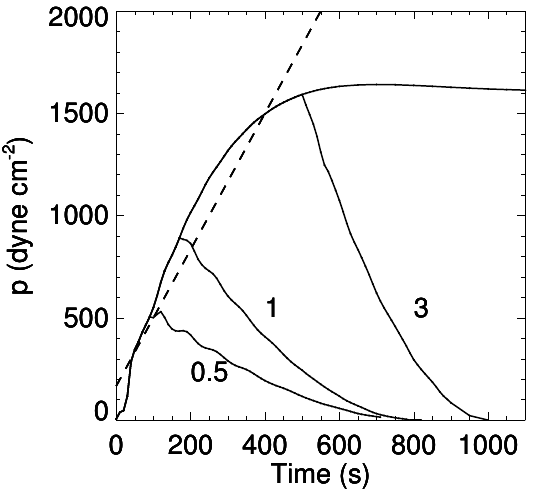
Figure 17: Pressure evolution obtained from a hydrodynamic simulation of a loop strand ignited by heat pulses of different duration (0.5, 1, 3 times the loop decay time, see text) and with a continuous heating. Most of the rise phase can be reasonably described with a linear trend (dashed lines). Image reproduced with permission from Reale (2007), copyright by